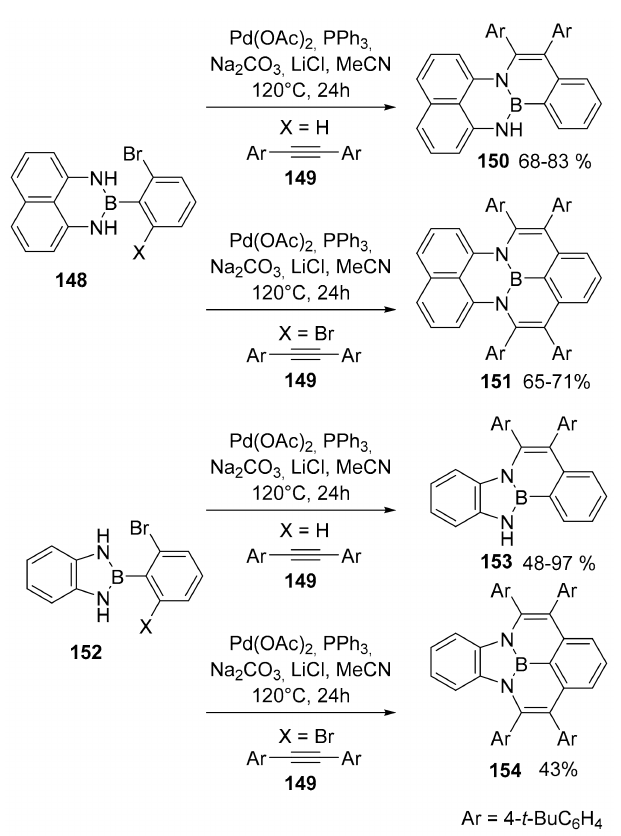
Scheme 36. Synthesis of compounds 150 , 151 , 153 and 154